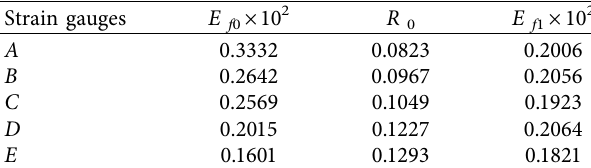
Table 3: Relevant parameters of regression equation.